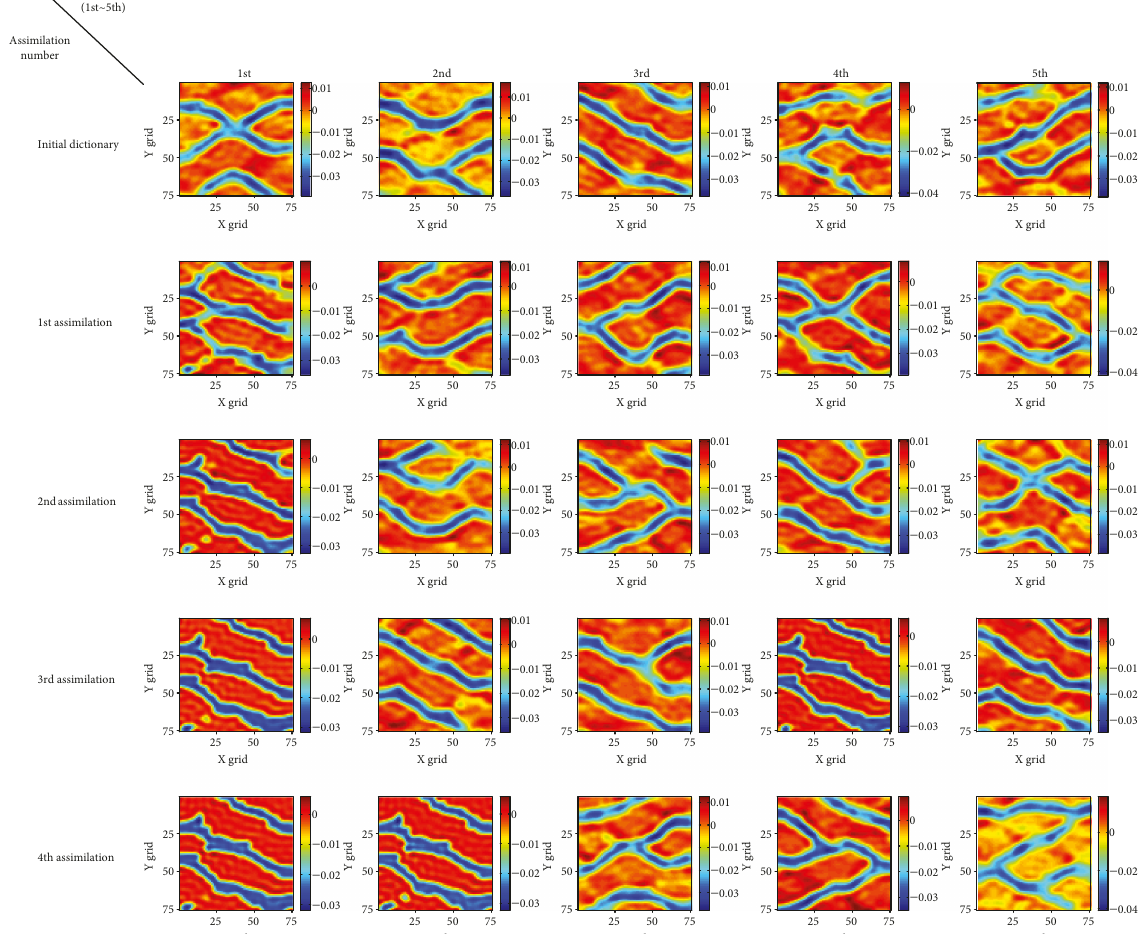
Figure 12: Evolution of realizations in the dictionary matrix D during multiple data assimilation (Case